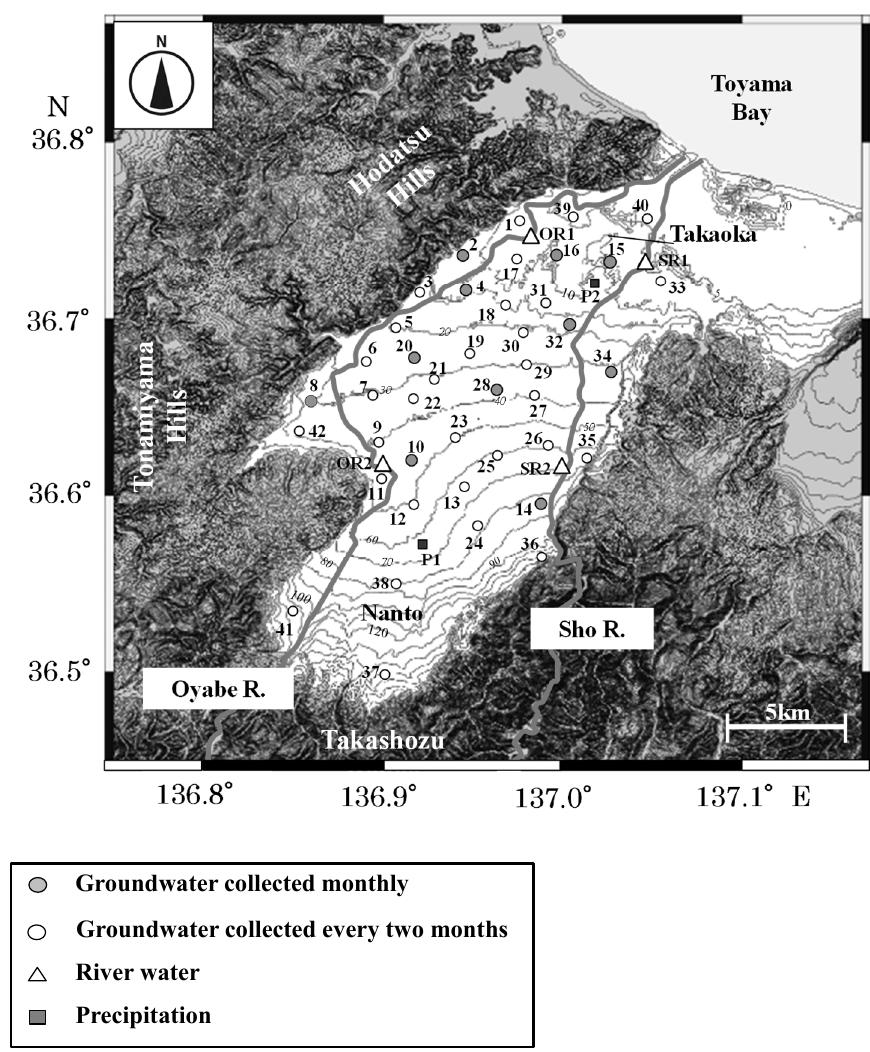
Figure 2. Location of water samples in Sho River alluvial fan. The contour intervals are 10 m.